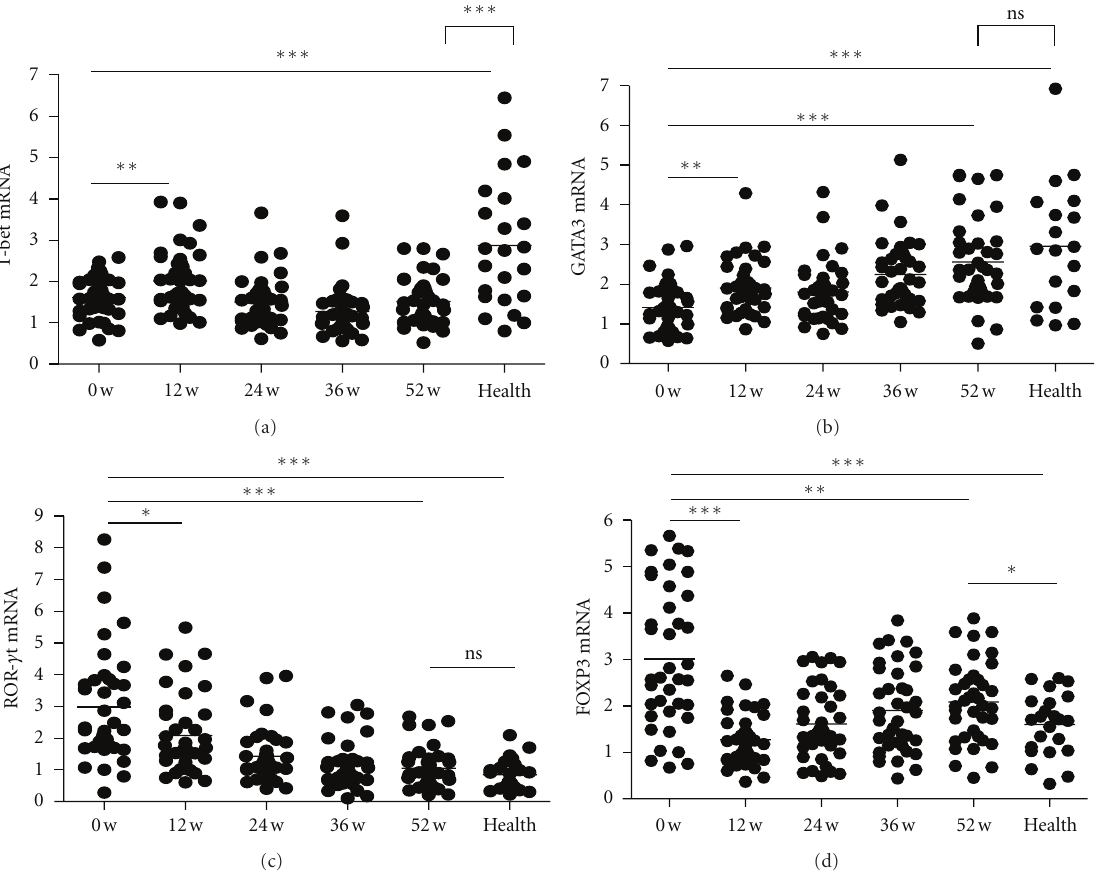
Figure 2: Changes in mRNA expressions of critical transcriptional factors for CD4 + T-cell subpopulations in response to telbivudine treatment. PBMCs from the healthy controls and CHB patients treated with telbivudine were used to detect the relative mRNA expression levels of the CD4 + T-cell subtype-specific transcription factors by qPCR. ∗ P < 0 . 05, ∗∗ P < 0 . 01, and ∗∗∗ P < 0 . 001 versus the respective baseline or 52-week value. Ns: no